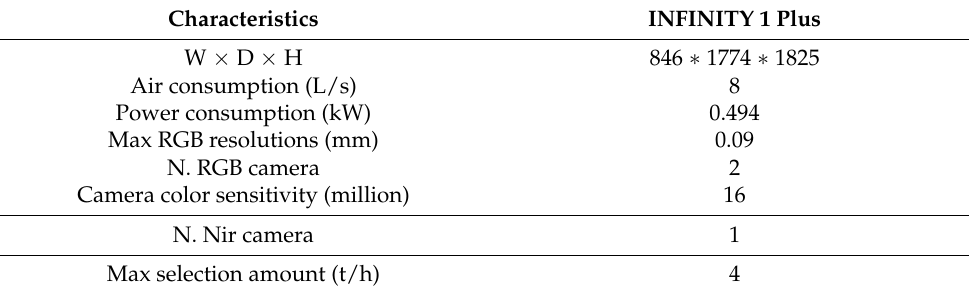
Table 1. Sorting machine characteristics.